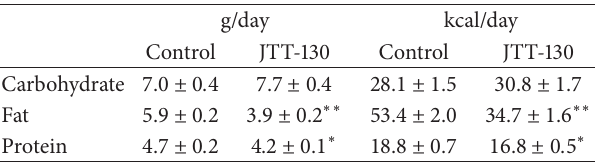
Table 3: Effects of JTT-130 on daily macronutrient consumption during the treatment